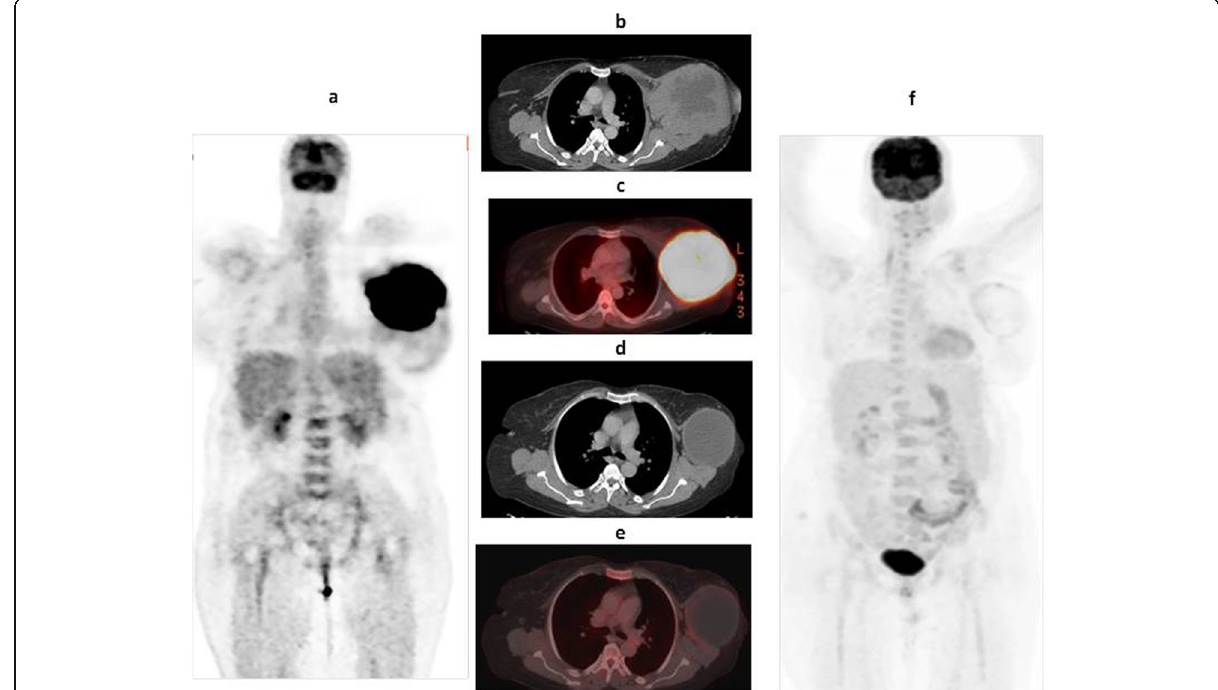
Fig. 1 A 51-year-old female patient, recently diagnosed case of NHL (large B cell type). Initial PET/CT study revealed large hypermetabolic mass at the left axilla and axillary tail of left breast in whole body PET MIP image ( a ), measuring about 16 x 16 x 15 cm with central breaking down in axial CECT image ( b ) and achieving 19 SUL peak in corresponding fused PET/CT image ( c ). Follow-up PET/CT study revealed smaller metabolically inactive lesion in whole body PET MIP image ( f ) that measured 10 x 9.5 x 9.3 cm in axial CECT image ( d ) denoting PR according to RECIST 1.1, yet showing no FDG uptake in corresponding fused PET/CT image ( e ) denoting CMR according to PERCIST